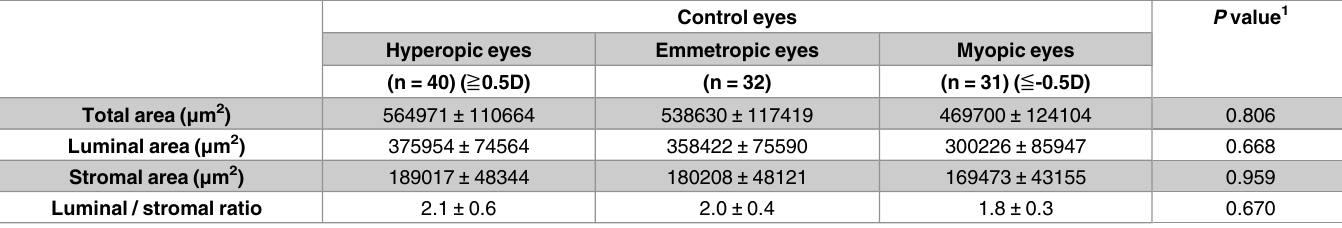
Table 3. Comparison of the choroidal area between the control hyperopic, emmetropic, and myopic eyes.